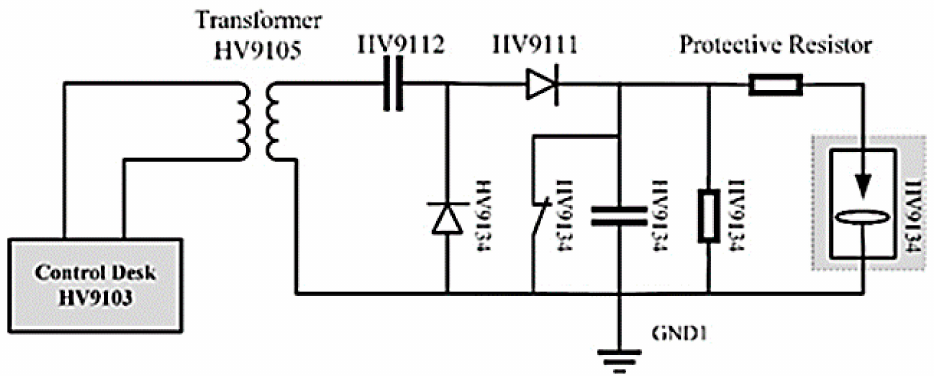
Figure 8. Schematics for the DC